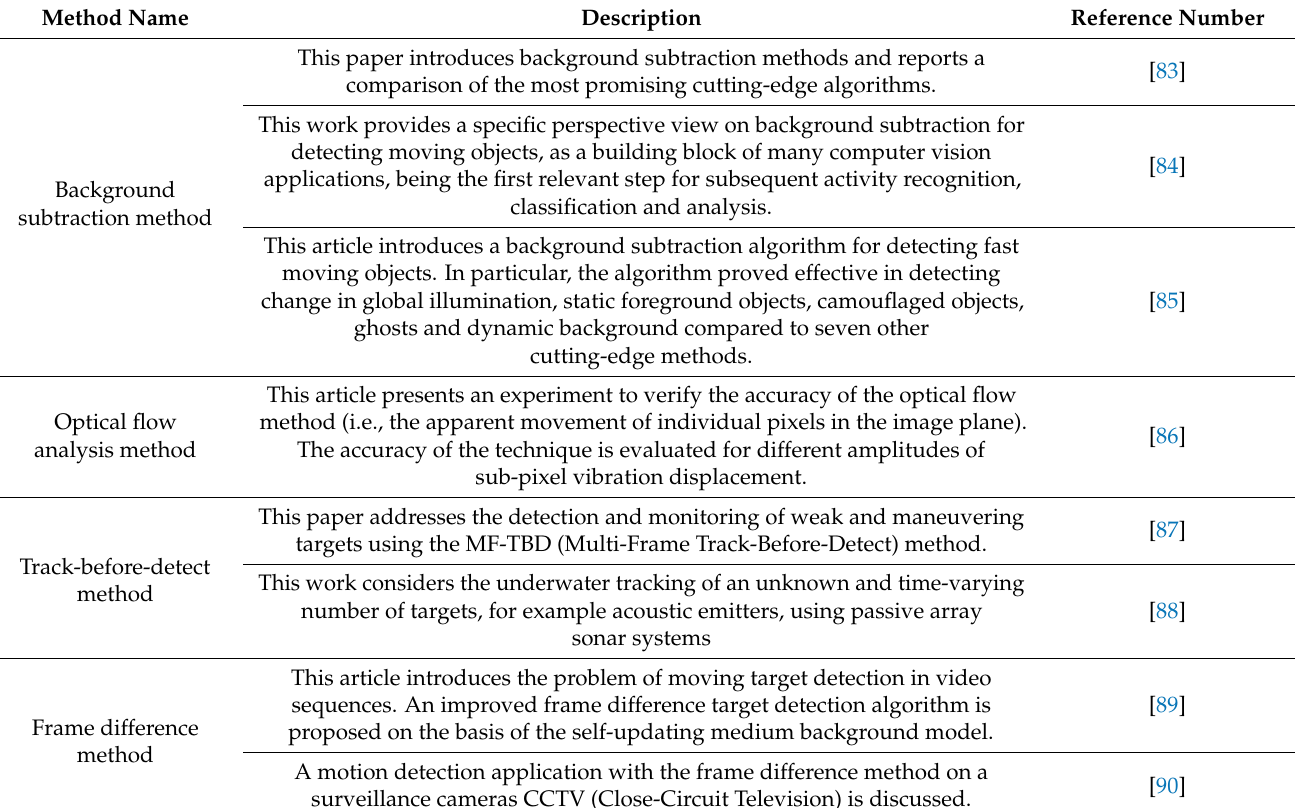
Table 1. Non-AI-based methods for SSA space debris